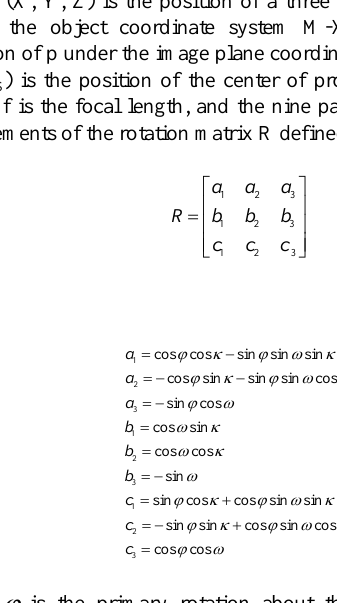
where  is the primary rotation about the Y-axis,  is the secondary rotation about the X-axis, and  is the tertiary rotation about the Z-axis.